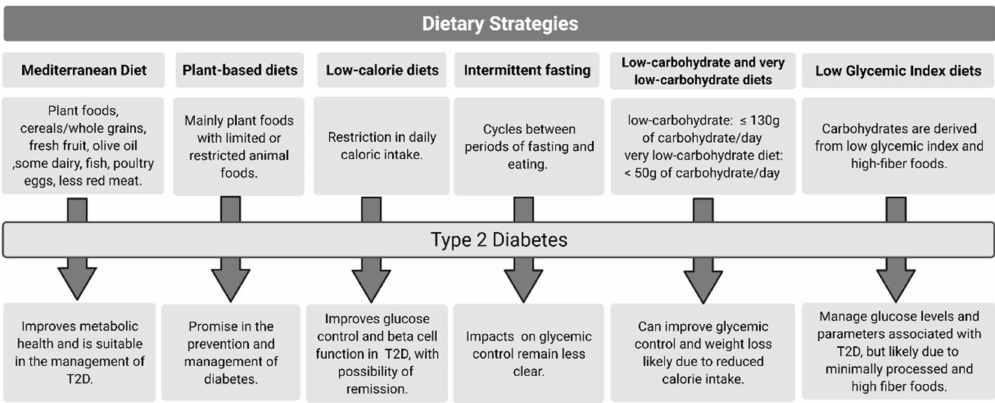
Figure 1. Dietary strategies and key outcomes for type 2